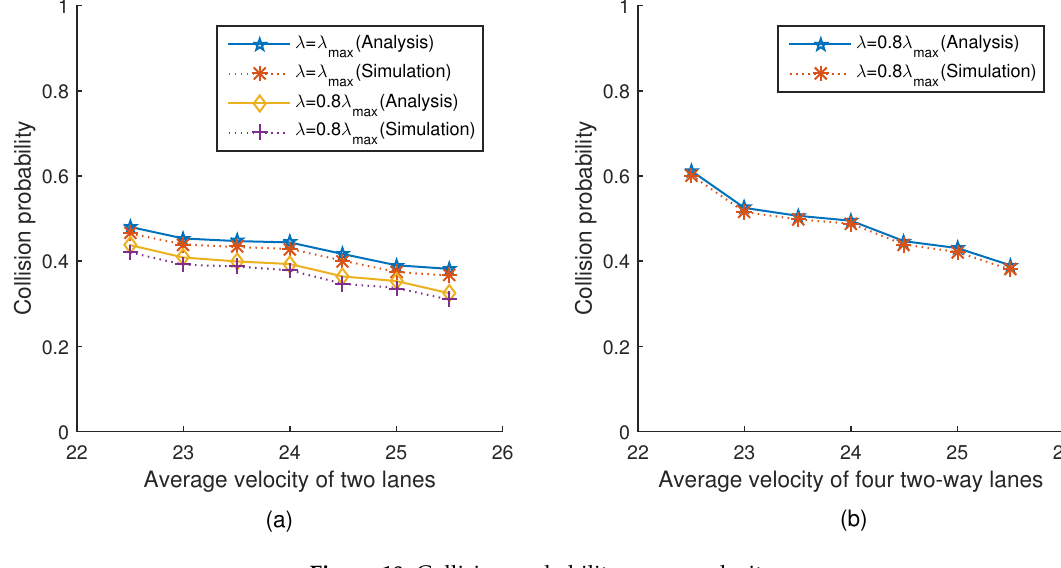
Figure 10. Collision probability versus